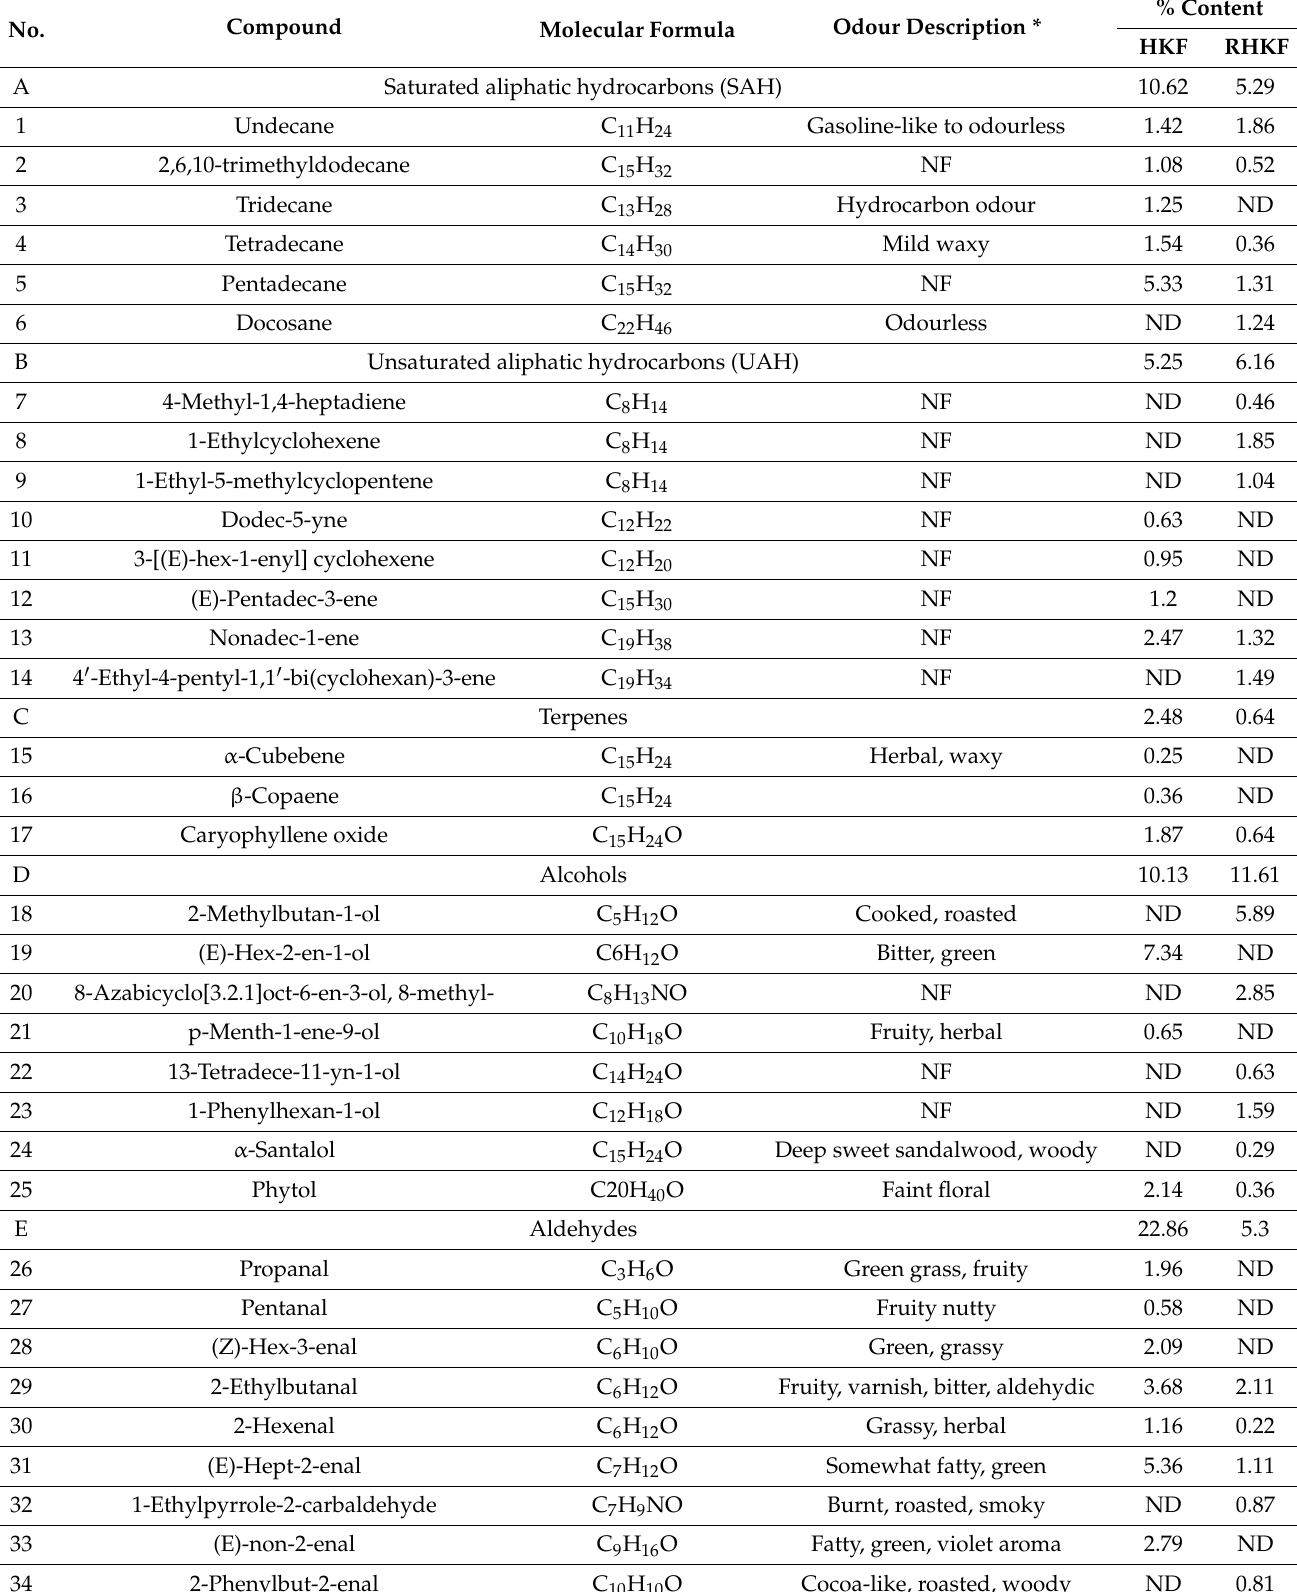
Table 3. Odour and relative content of the identified volatile compounds in raw and roasted avo- cado